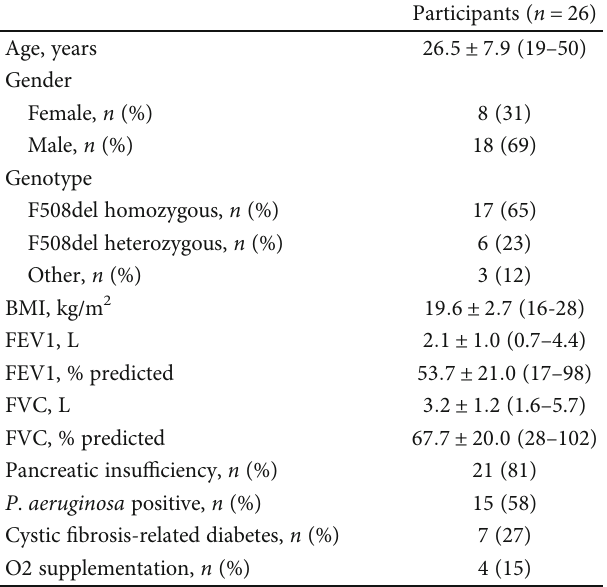
Table 2: Patient characteristics and pulmonary function